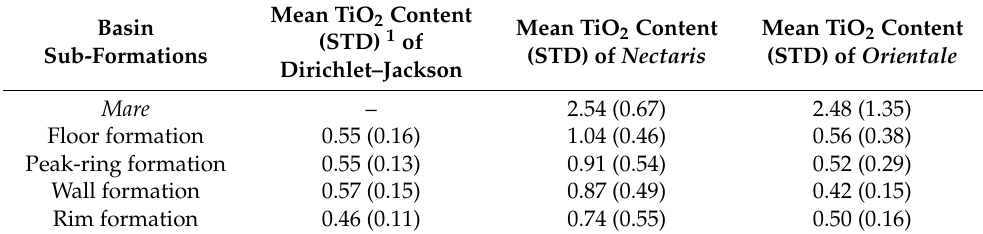
Table 2. Mean TiO 2 content in the sub-formations of the three basins.